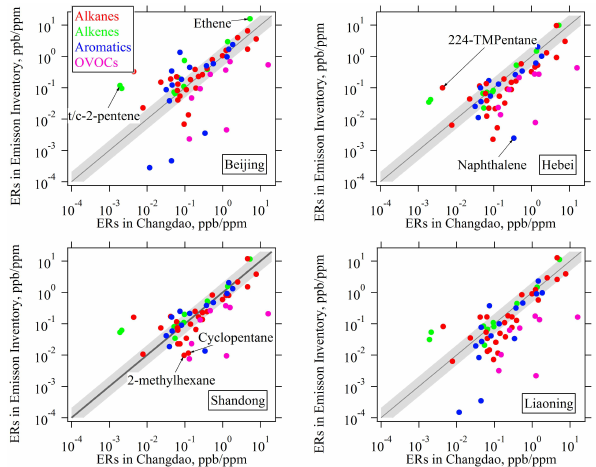
Fig. 5. Comparisons of emission ratios of VOCs to CO determined in the Changdao campaign with those in emission inventory data of the four surrounding provinces (Beijing, Hebei, Shandong and Liaoning) (Zhang et al., 2009). The black lines indicate the 1 : 1 relationship, and the gray areas show agreements within a factor of